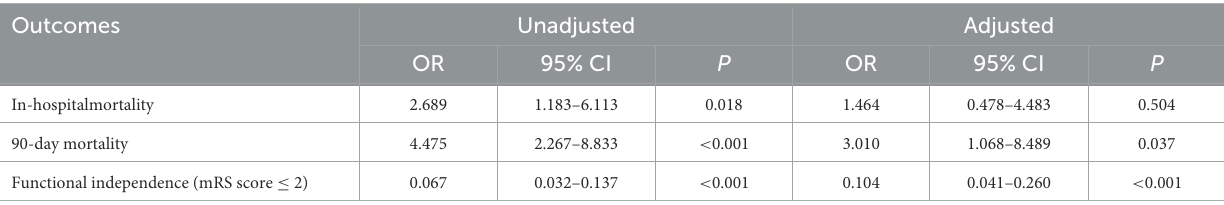
TABLE 3 Impacts of poststroke pneumonia on clinical outcomes in the multivariate model.